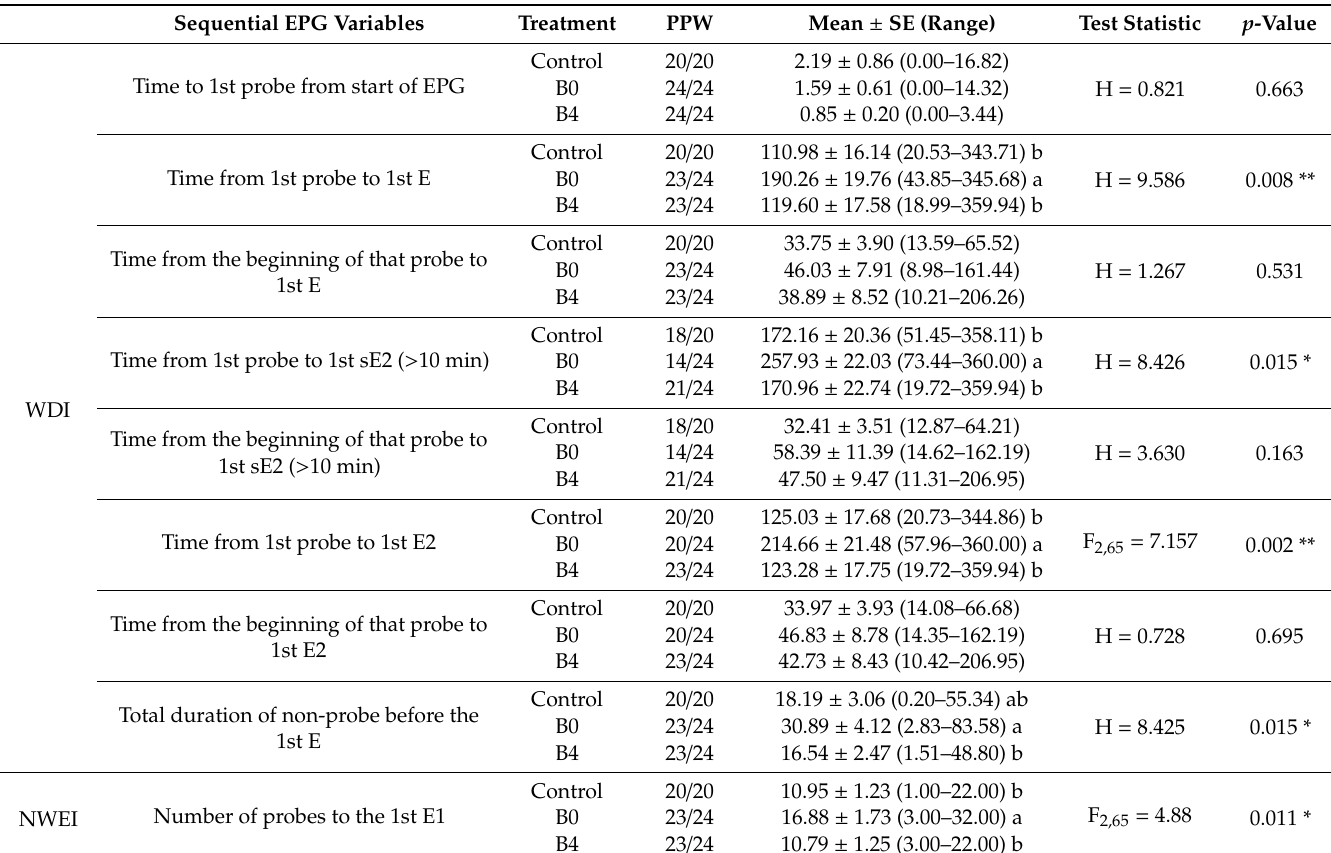
Table 3. Mean ± standard error (min) of sequential electrical penetration graph (EPG) variables and their ranges in parenthesis for the feeding behavior of Aphis gossypii exposed to melon plants at 0 (fresh residue) (B0) and 4 days (B4) after sprayed BTH (benzo-(1,2,3)-thiadiazole-7-carbothioic-acid S-methyl ester), using water-sprayed plants as control, during a six-hour